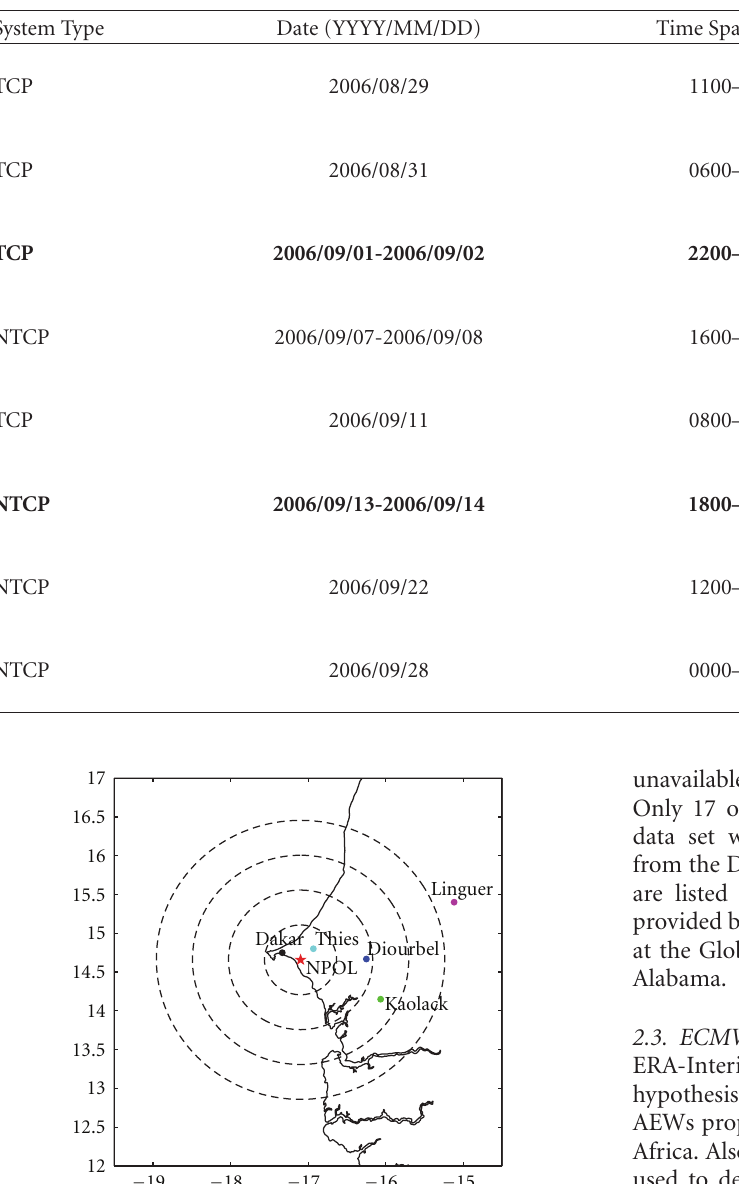
Table 1: Events selected for analysis are presented, and the parameters listed include the system type (TCP or NTCP), the date of NPOL observation, the time span in universal time, and the radiosondes that were launched during each of the cases. TCP (NTCP) refers to systems that produced (did not produce) tropical cyclones. The emboldened cases represent the most representative events for each case type.